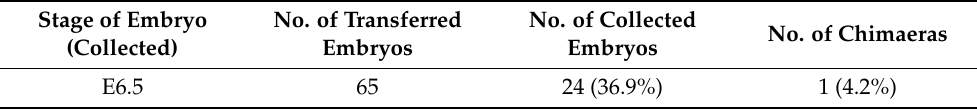
Table 2. The paAFSCs contributed to the E6.5 chimaera.